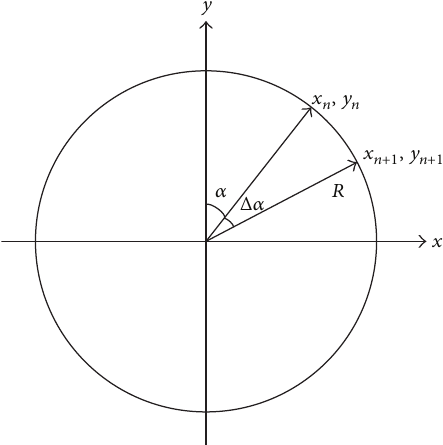
Figure 1: Rotation of vector 𝑅 in the coordinate plane 𝑥 - 𝑦